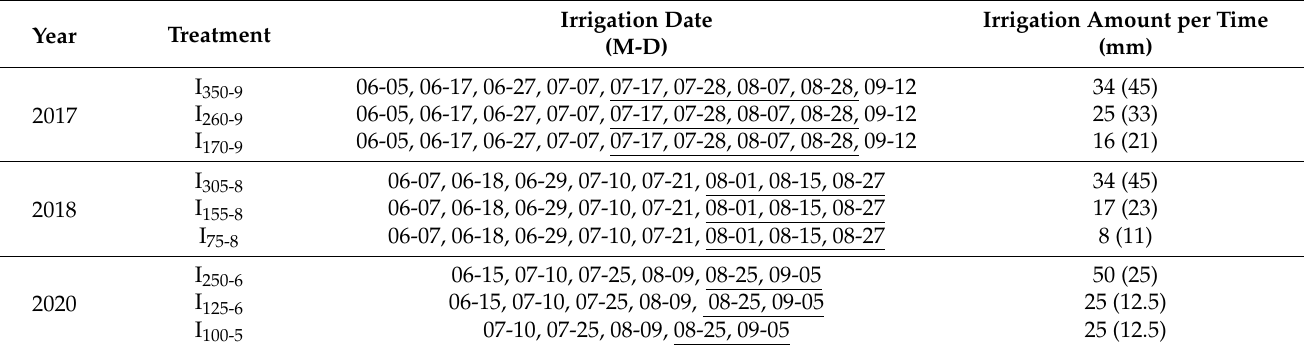
Table 1. Irrigation schedules of different treatments in 2017, 2018 and